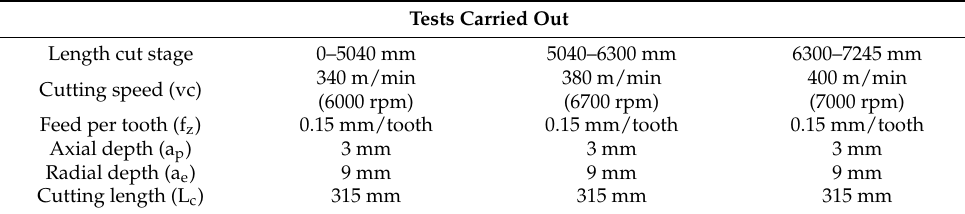
Table 2. Test cutting parameters.